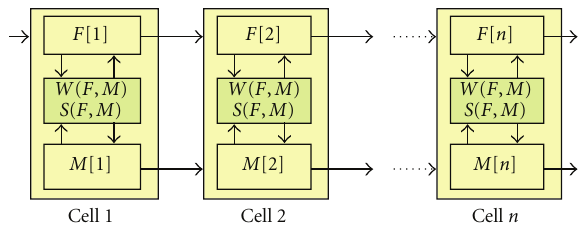
Figure 2: Block diagram of systolic array.